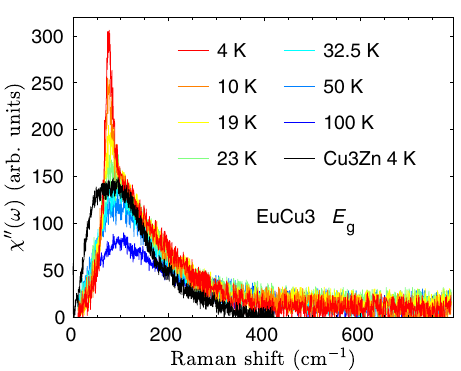
Fig. 6 Comparative Raman studies of EuCu 3 and Cu 3 Zn. We select the E g magnetic Raman continua in EuCu 3 at several temperatures. For a comparison, we also plot the E 2g magnetic Raman continuum in Cu 3 Zn at 4 K with the Raman shift scaled by the superexchange energy ratio of 1.9.